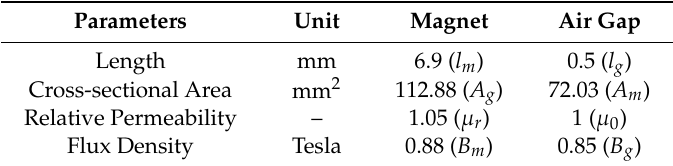
Table 4. The parameters of the designed